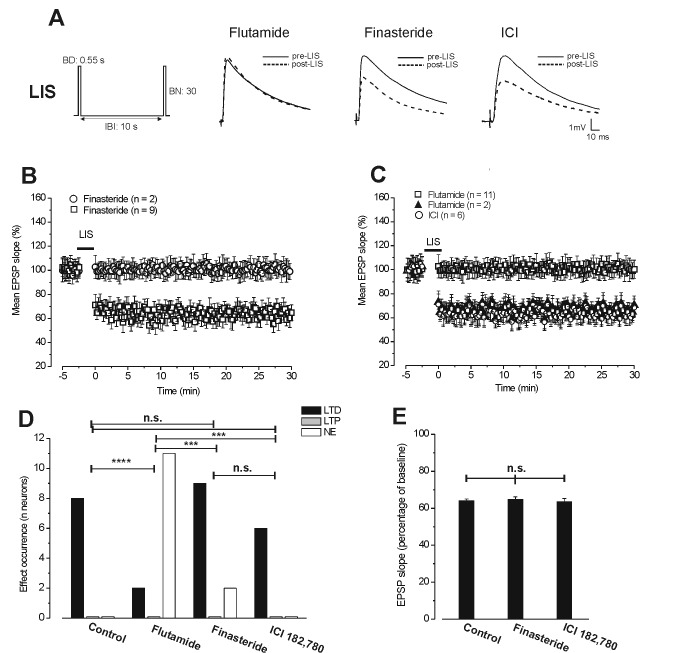
Involvement of androgens in the induction of LTD by the LIS protocol.
A. Averaged traces (n = 20) of EPSPs evoked before (thin traces: pre-LIS) and after LIS (dashed traces: post-LIS) in the presence of flutamide, finasteride and ICI 182,780. (Left) Schematic drawing of stimulation pattern inducing LTD (LIS). B and C. Time courses of the responses induced by LIS under block of the DHT synthesizing enzyme (B) and of ARs or ERs (C). B. Under finasteride, LIS induces LTD (open square, n = 9) and no effect (open circle, n = 2). C. Under flutamide, LIS has no effect (open square, n = 11) or induces LTD (filled triangles, n = 2), while under ICI 182,780 it only induces LTD (open circles, n = 6). Note that under block of ARs (flutamide) LTD is prevented in the majority of cases, while it is still induced under block of DHT synthesising enzyme (finasteride) and of ERs (ICI 182,780). D. Frequency occurrence (number of neurons) of LTD (black columns), LTP (grey columns) and no effect (NE, white columns) induced by LIS in the control condition and in the presence of flutamide, finasteride and ICI 182,780 (χ2 test: ***P<0.005, **** P<0.001, n.s. = no significant). E. In this and in the subsequent figure columns express the mean ± SE of the EPSP slopes (percentage of baseline) within 2.5-min intervals evaluated at 30 min post-stimulus. Here, comparison between the amplitudes of LTD induced by LIS in control condition (n = 8) and in the presence of finasteride (n = 9) or ICI 182,780 (n = 6) (one-way ANOVA: n.s = no significant).